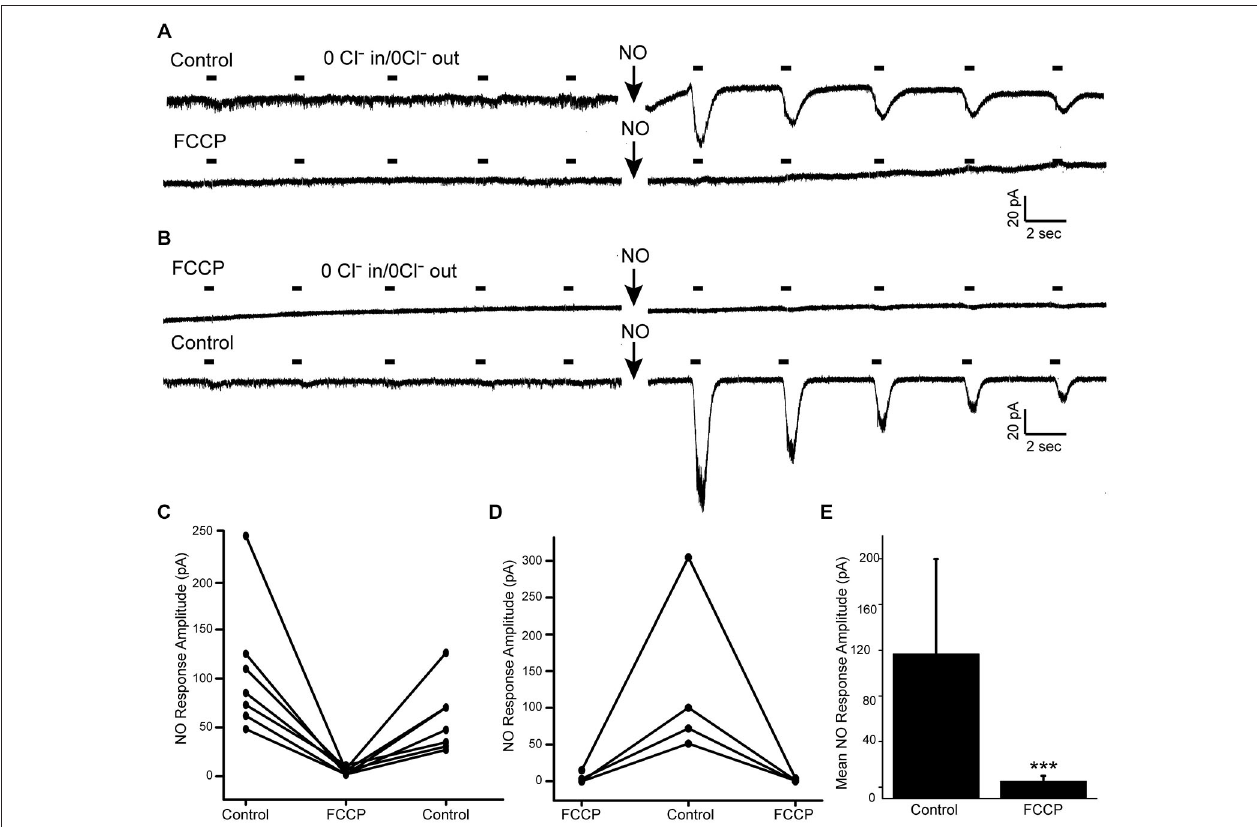
where FCCP is applied first. No GABA-gated currents are observed either before or after NO. (B) (bottom), A recording made from the same cell after washout of FCCP. NO elicits an increase in the GABA-gated current demonstrating a NO-releasable Cl − store in this cell. (C,D) , GABA-gated current amplitude data are plotted for each cell recorded. Cells are sorted according to the order of FCCP application (after control, (C) ; before control, (D) ). Data plotted are the GABA-gated current amplitudes recorded just after NO application. (E) , Combined mean current amplitude data are plotted to compare control to FCCP. *** denotes p <